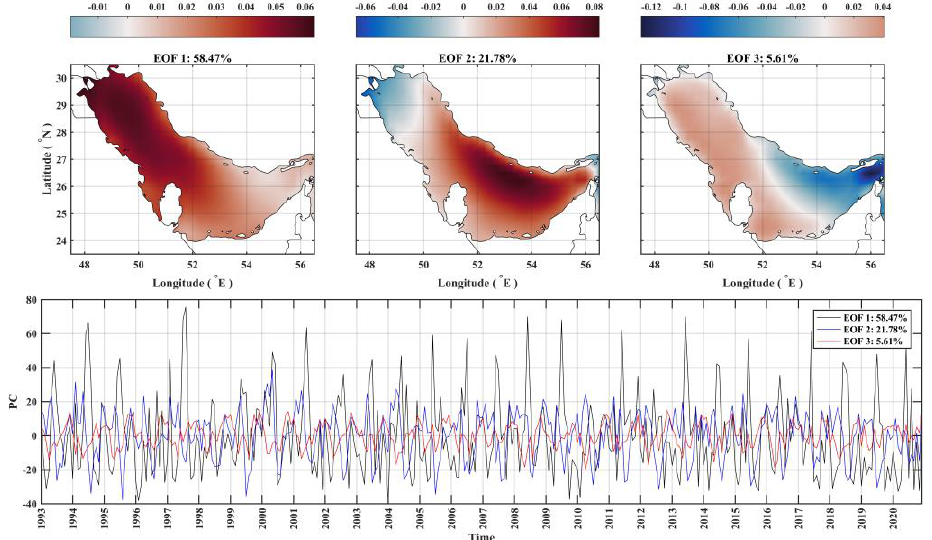
Figure 3. Spatial and temporal components of the three EOF modes of wind speed.